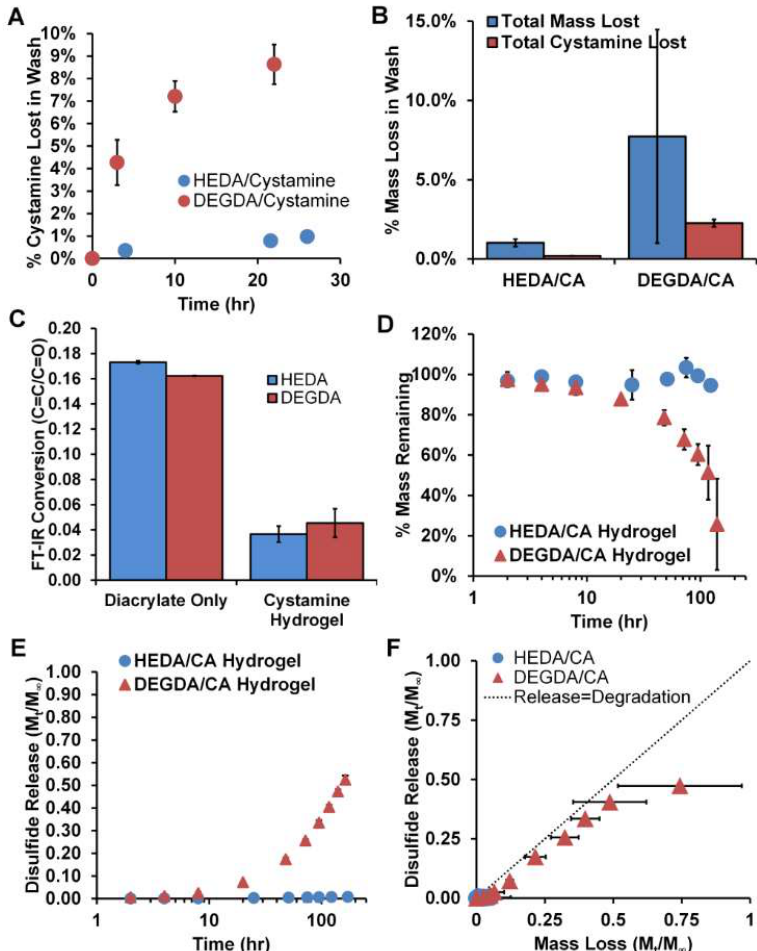
Figure 2. Disulfide hydrogel characteristics. ( A ) % CA loss of total CA added after washing in dimethylsulfoxide (DMSO), ( B ) % mass loss of hydrogel CA based on total mass before and after wash, and ( C ) conversion with FT-IR. ( D ) % mass remaining during sink condition degradation at 37 °C, ( E ) disulfide release, and ( F ) comparison of disulfide release to mass loss over time. n = 3, M ± SD.